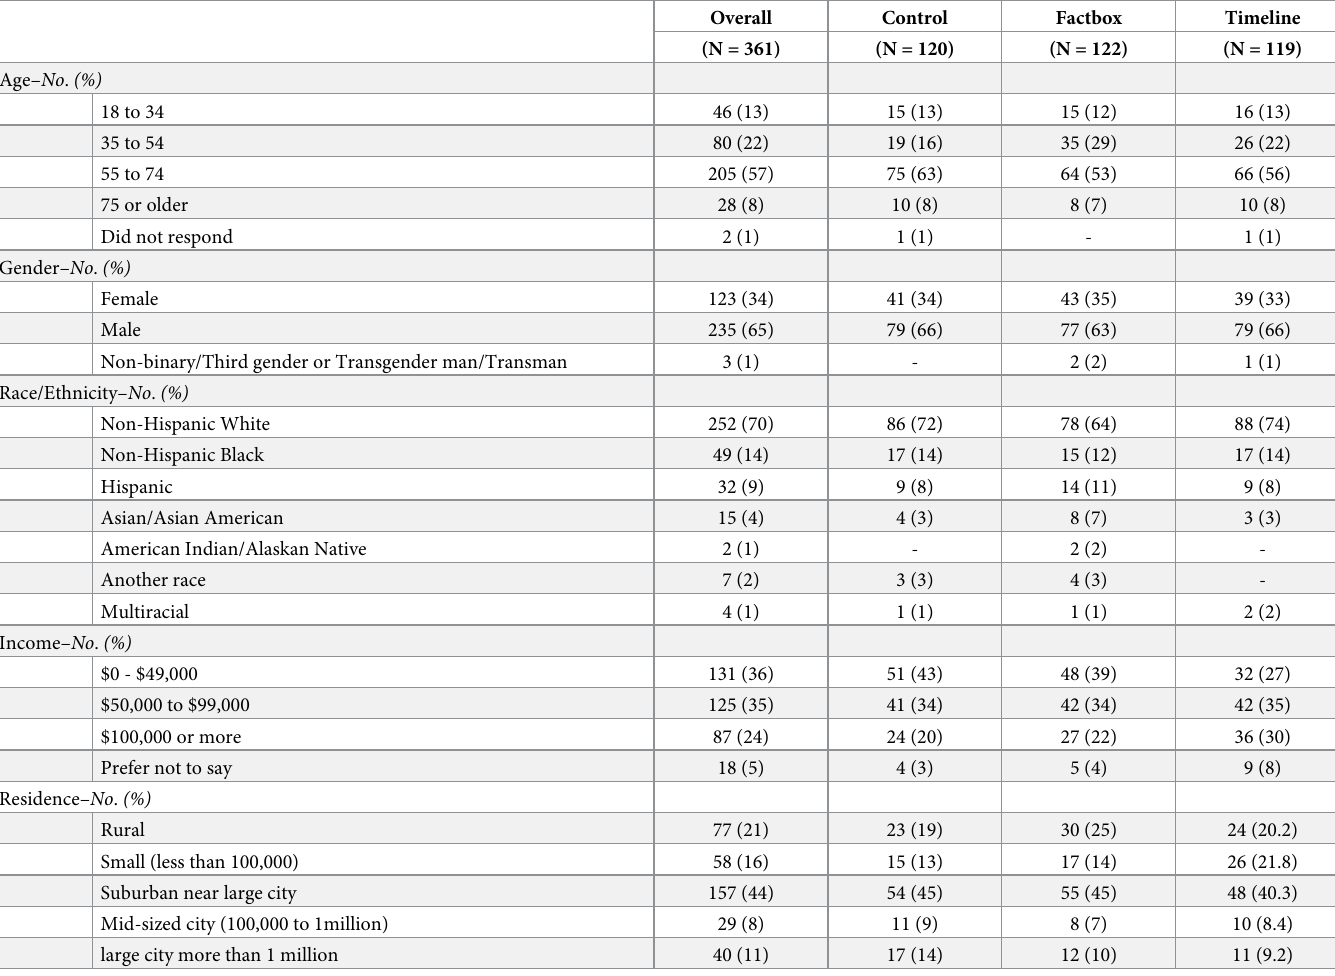
Table 1. Respondent characteristics overall and according to group